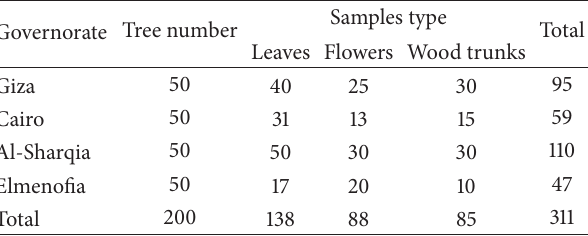
Table 1: Eucalyptus tree collected samples in the Delta region. Governorate Tree number